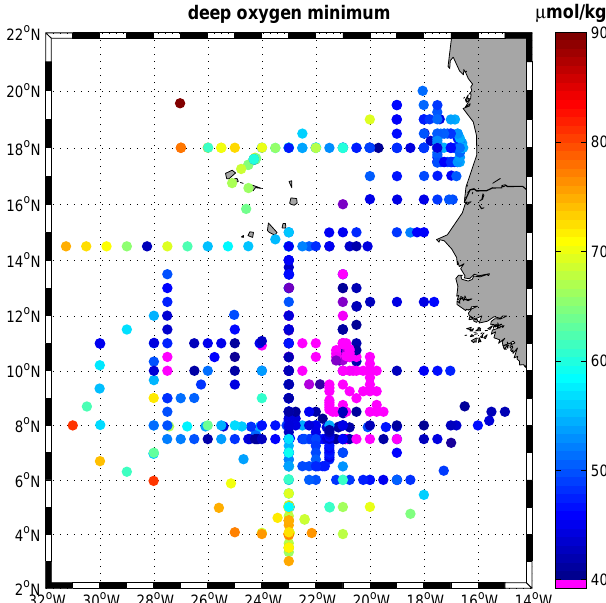
Figure 3. Minimum oxygen concentration below 200m (represent- ing the deep oxygen minimum) as obtained from CTD station data taken during the period 2006–2013. Oxygen concentration at the deep oxygen minimum below 40 µmolkg − 1 is marked by purple